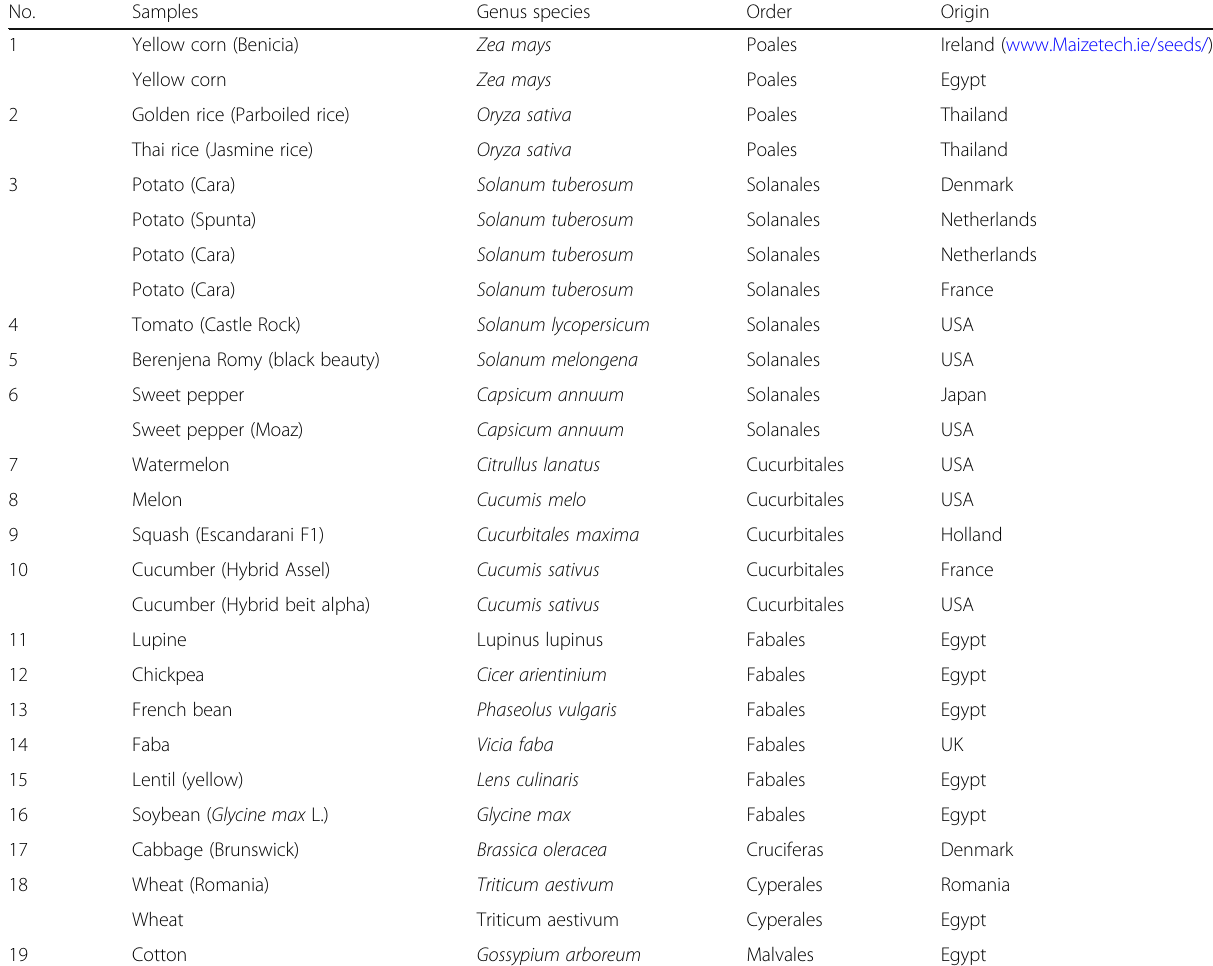
Table 1 List of plant seeds and tubers collected for the present investigation No.